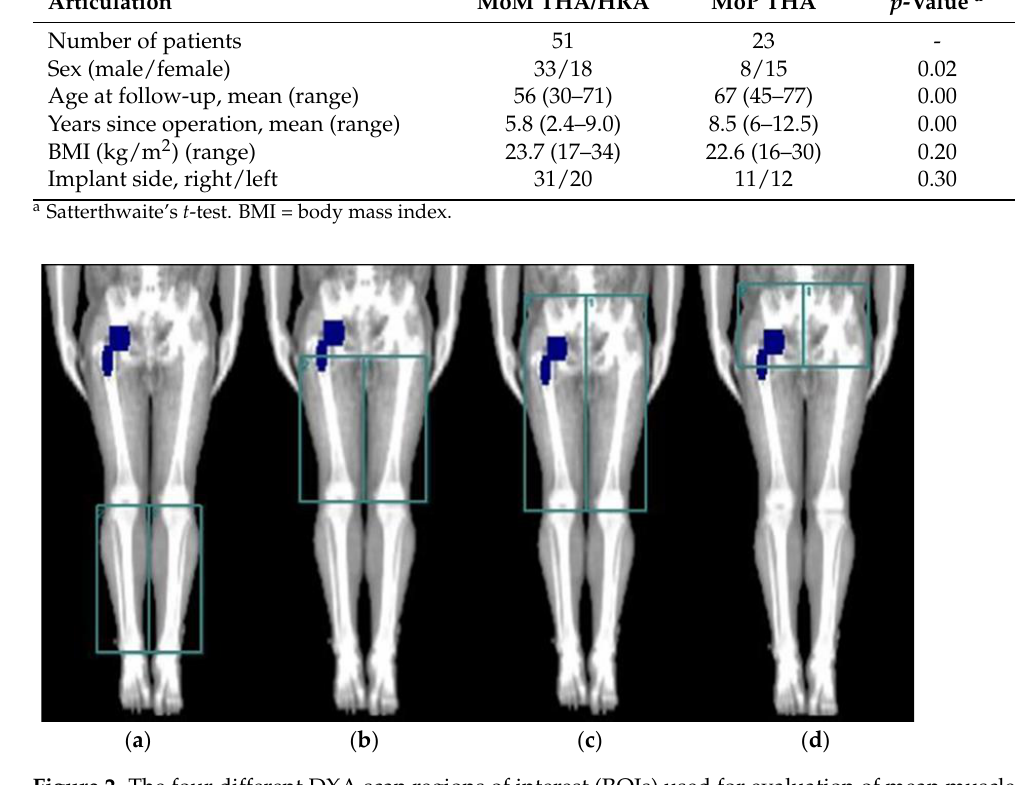
Figure 2. The four different DXA scan regions of interest (ROIs) used for evaluation of mean muscle mass of the implant-side and the non-implant-side leg. ( a ) calf area, ( b ) thigh area, ( c ) hip and thigh area, and ( d ) hip area.